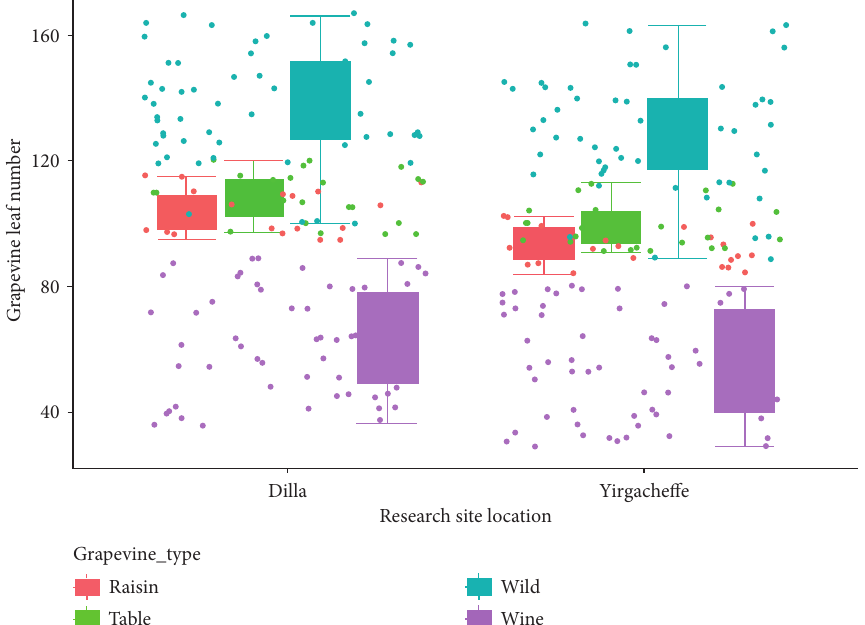
Figure 8: Response of leaf number to grapevine types and locations.